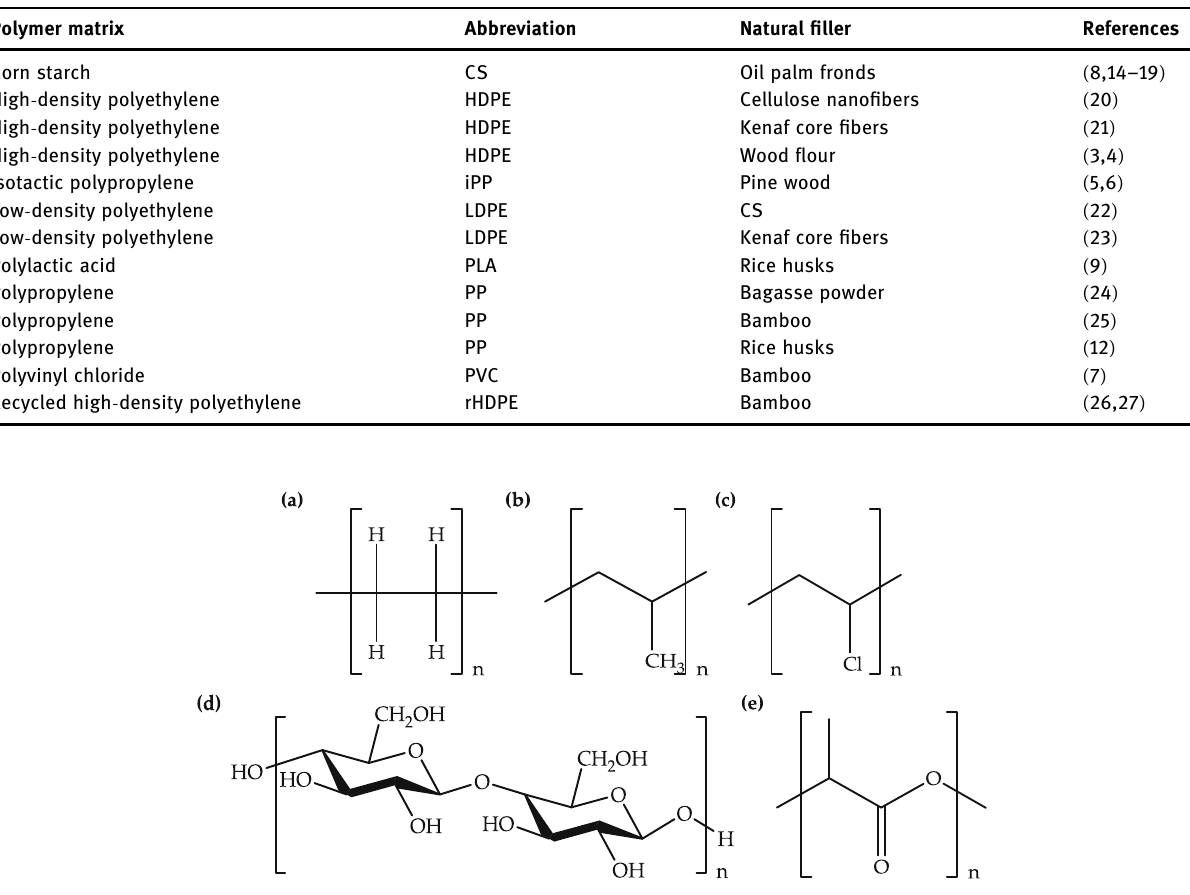
Figure 1: Chemical structures of ( a ) PE, ( b ) PP, ( c ) PVC, ( d ) CS, and ( e )